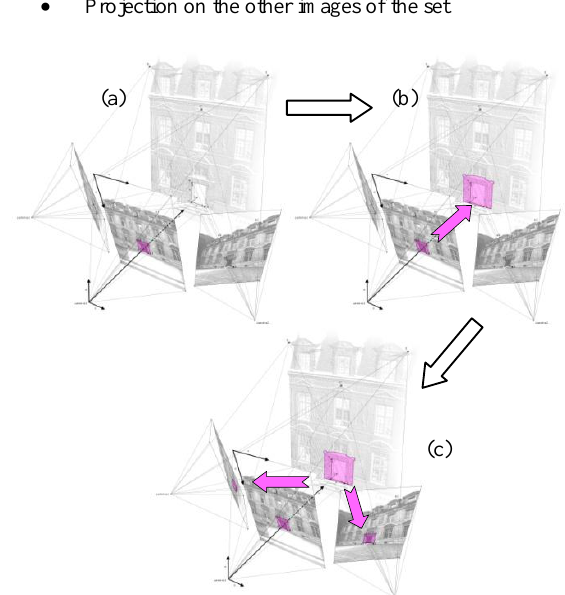
Figure 6: Steps of transfer: (a) definition of the annotation on the middle image, (b) research of X, Y and Z coordinate of the area, (c) projection on the other